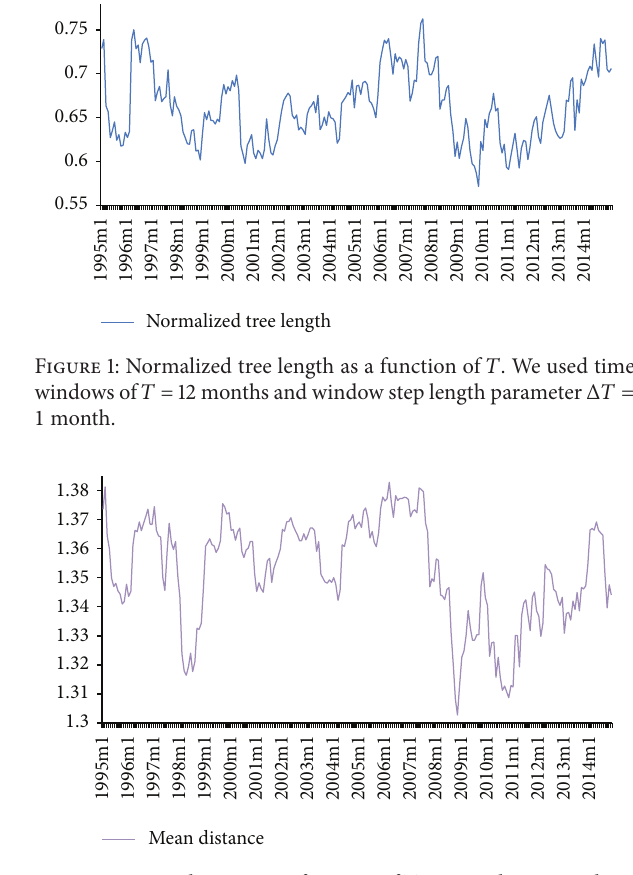
Figure 2: Mean distance as a function of 𝑇 . We used time windows of 𝑇 = 12 monthsandwindowsteplengthparameter Δ𝑇 = 1